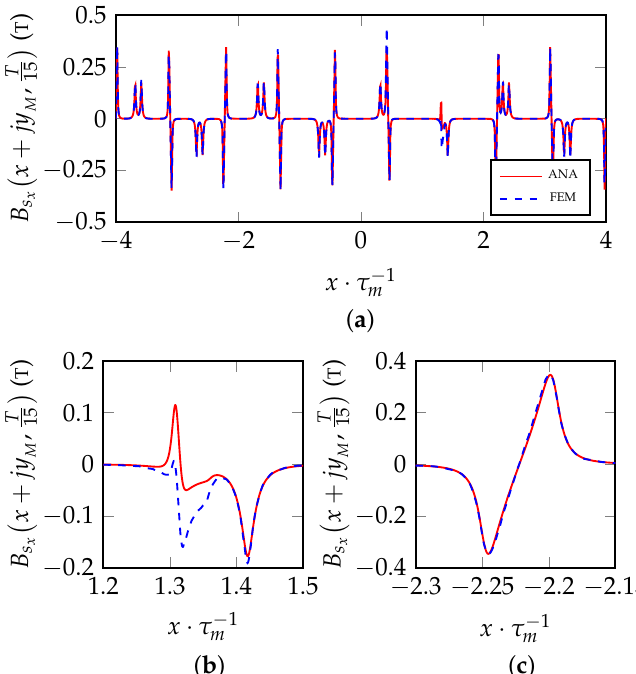
Figure 11. Analytical and FEM no-load flux density tangential component on the middle mechanical air-gap line of the slotted machine of Figure 5a, with PM slider position corresponding to a time instant t = T/15 ( 4 τ m 4 τ m N x = 1000, N h = 150); ( b , c ) are two different selective zooms x − ≤ ≤ of ( a